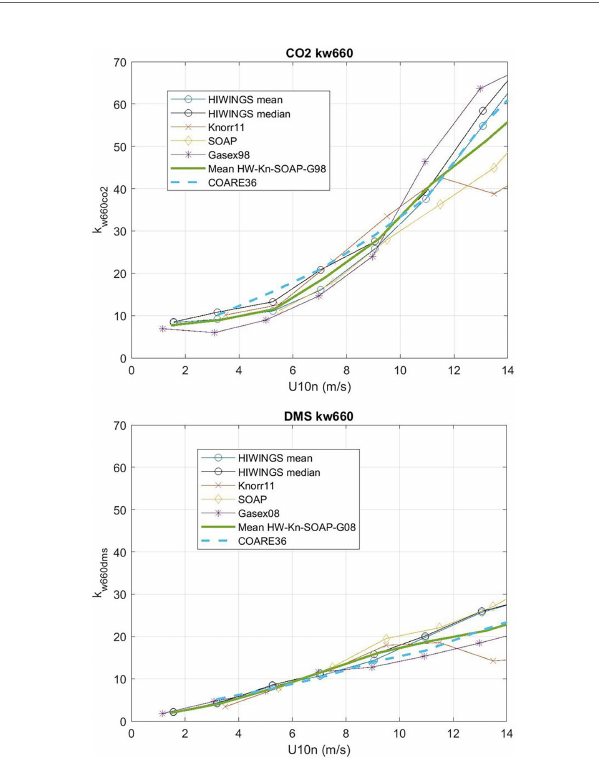
FIGURE 9 | Wind speed bin-averaged k w 660 from HiWinGS, Knorr11, SOAP, GasEx98 and GasEx08 fi eld programs: upper panel for CO 2 and lower panel for DMS. Both mean and median are shown for HiWinGS. The heavy green line is the mean of the fi ve estimates. The dashed line is the COARE36